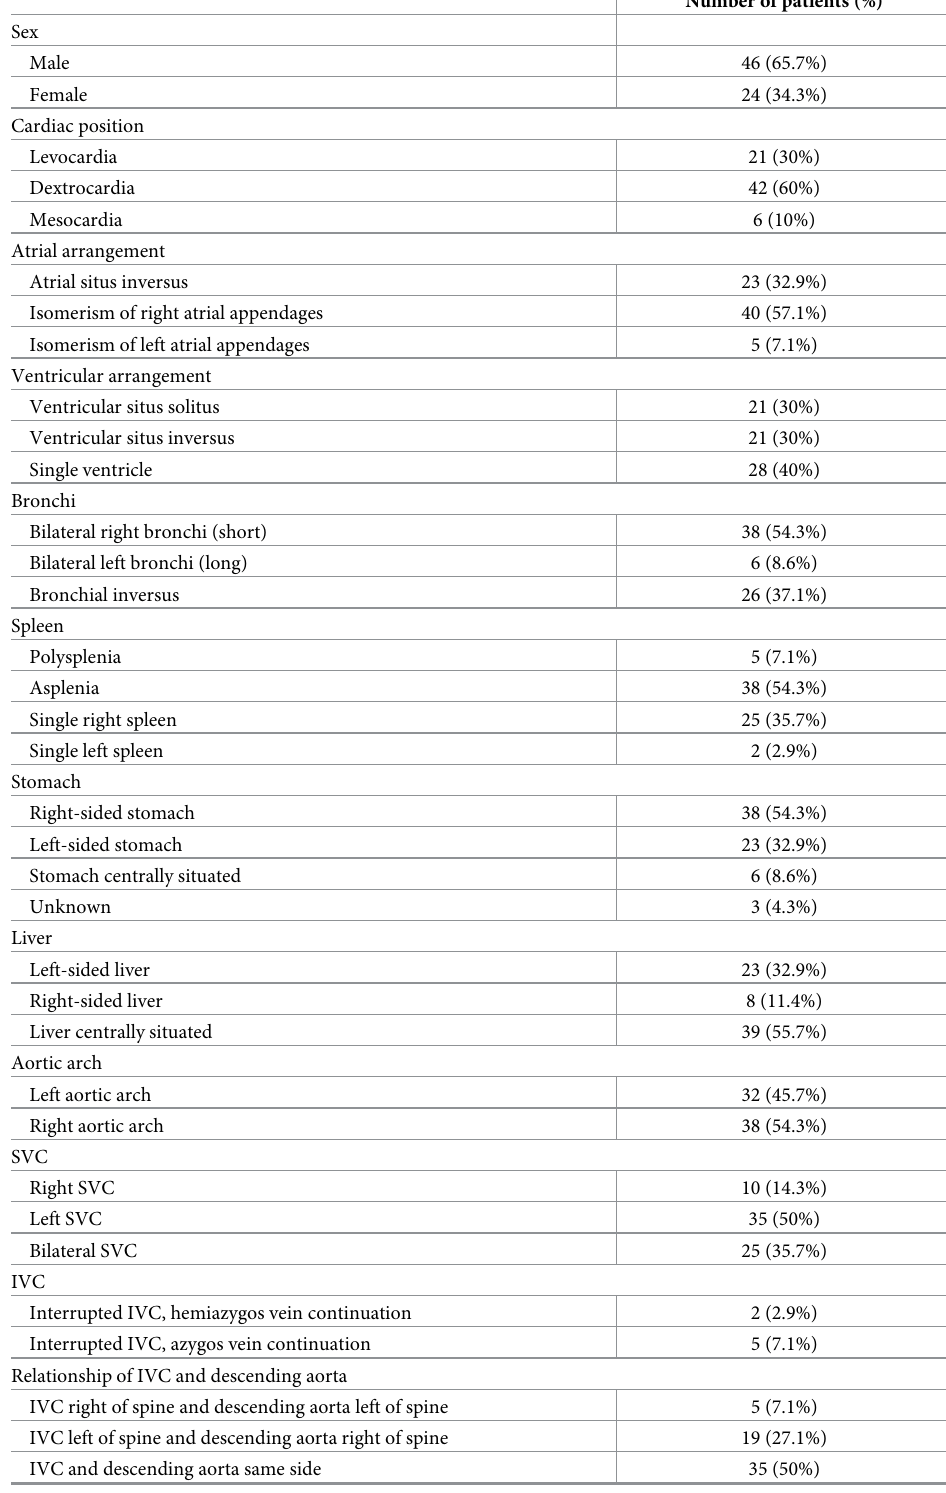
Table 1. Cardiac and extracardiac abnormalities in the patients with laterality